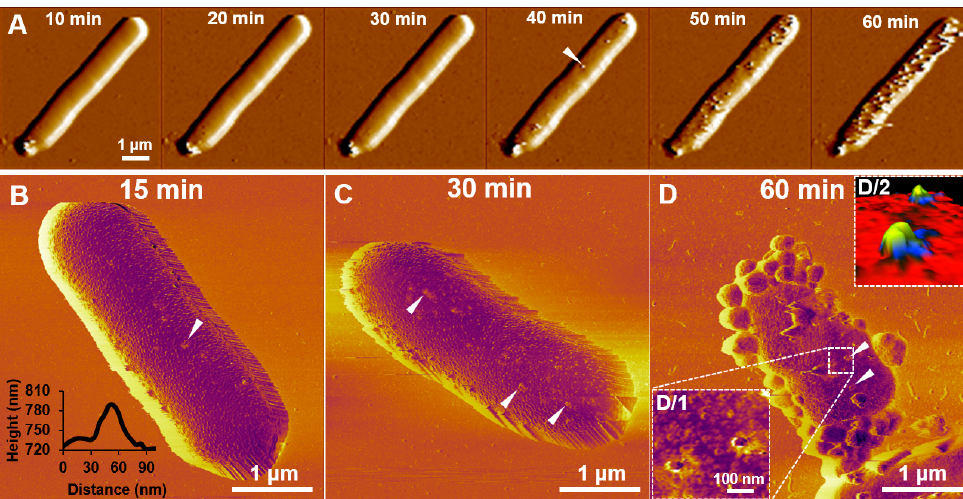
Figure 5. Viral infection causes bacterial cell surface roughening and bleb formation. ( A ) Amplitude- contrast image series of viruses docking on a single bacterial cell surface in native conditions at 25 °C. The white arrowhead points to a docked bacteriophage. Phase-contrast AFM images of E. coli bacteria fixed with glutaraldehyde 15 ( B ), 30 ( C ), and 60 ( D ) minutes post-infection. 60 min after infection bleb formation can be observed. White arrowheads point to docked bacteriophages. Insets show the enlarged region of two docked bacteriophages ( D/1 ) and their 3D representations ( D/2 ), yellow color shows the viral capsids and the black color shows the surface-bound tail fibers.